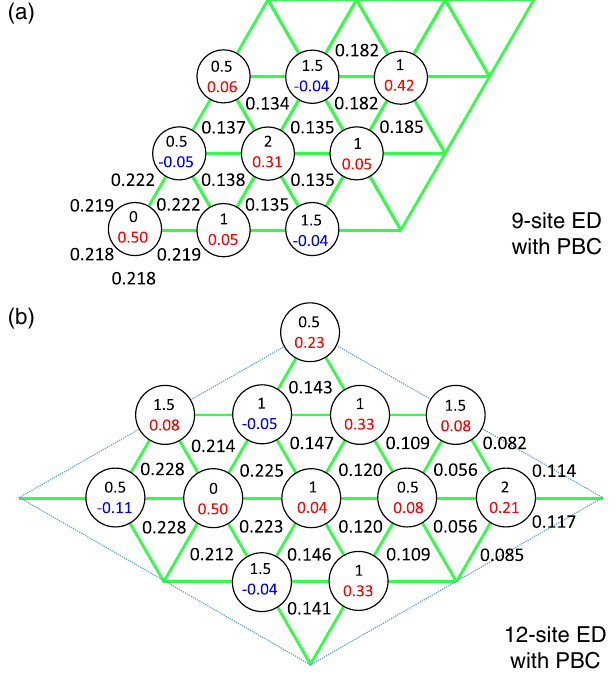
FIG. 4. Calculated ground state in the presence of the inho- mogeneous randomness using the (a) 9-site and (b) 12-site clusters with different PBC, under μ 0 H ¼ 1 . 5 T. The fitted k ¯ Δ parameters of model no. 2 ( ¼ 5 . 71 K, J zz 1 ¼ 10 . 9 K, J zz 2 ¼ 1 . 11 K, and g ¼ 13 . 6 ) are used. The black number in k ¯ Δ the circle is the inner gap of each pseudospin (the multiple of ), and the red and blue numbers are the spin-up and spin-down static dipole moments, h S z i . The numbers in the triangles display the i local order parameter calculated for the three spins at the corners of the respective triangle. The green lines depict the triangular